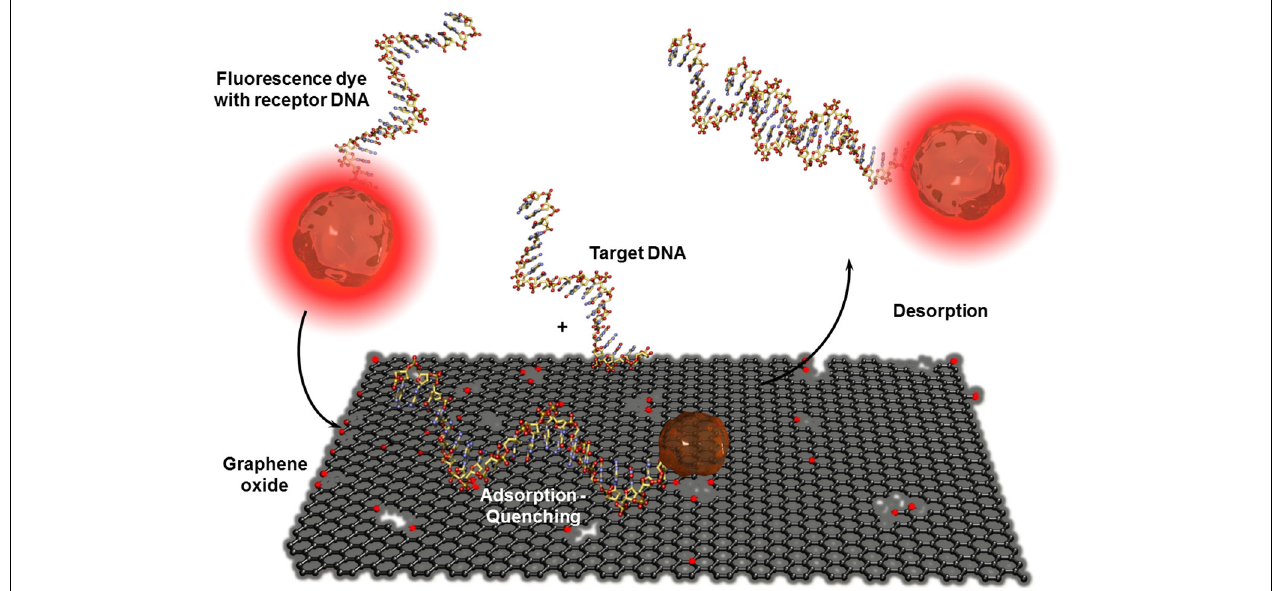
FIGURE 9 | Adsorption and desorption of a fluorescence dye modified receptor DNA on graphene oxide before and after hybridization with the corresponding target DNA. Graphene oxide quenches the fluorescence of